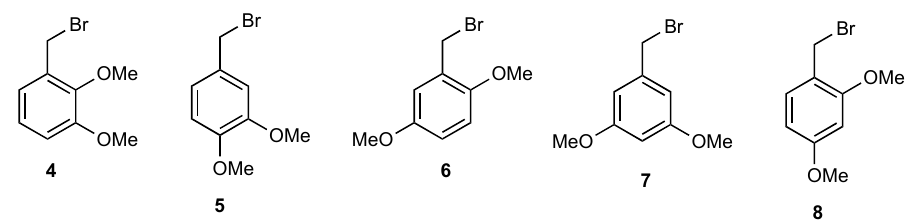
Figure 1. The other isomeric dimethoxybenzyl bromides.